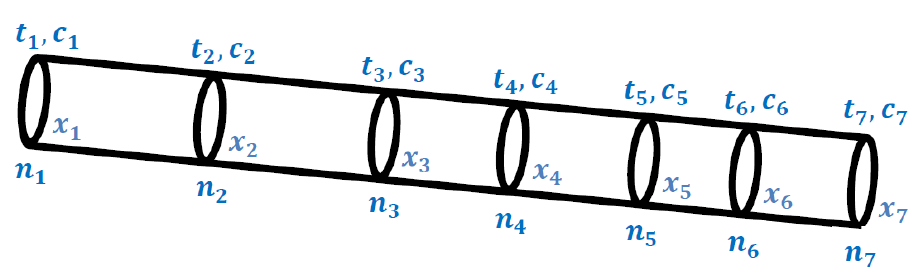
Figure 2. Representation of the system modeled. Here, t n is the temperature, whether measured or estimated (°C), c n is the airflow measured (m 3 /s), x n is the relative position of the control points or nodes (m), and n i is the node number.